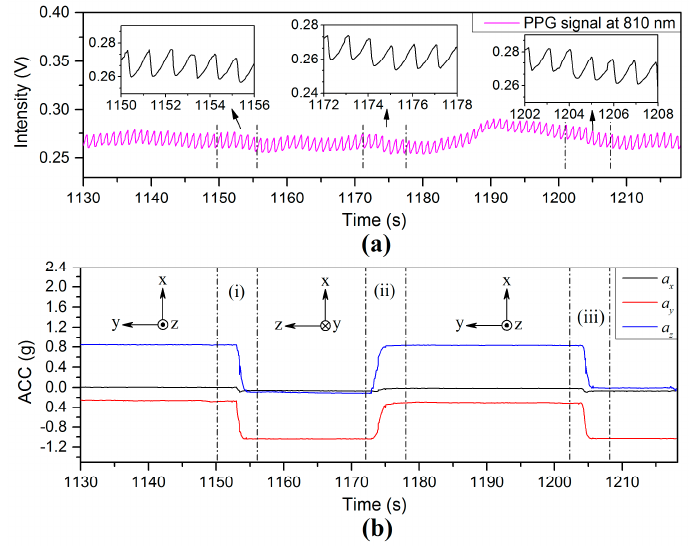
Figure 16. Illustration of ( a ) PPG and ( b ) ACC signals recorded from rotating wrist.